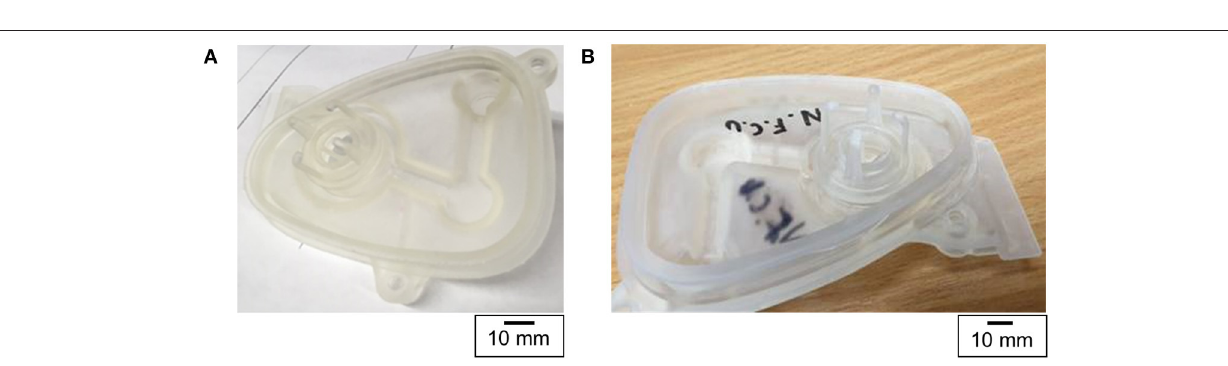
FIGURE 5 | Photograph of (A) the first and (B) the second manifold cover prototypes made using 3D printing. The letters NFCU stand for Not For Clinical